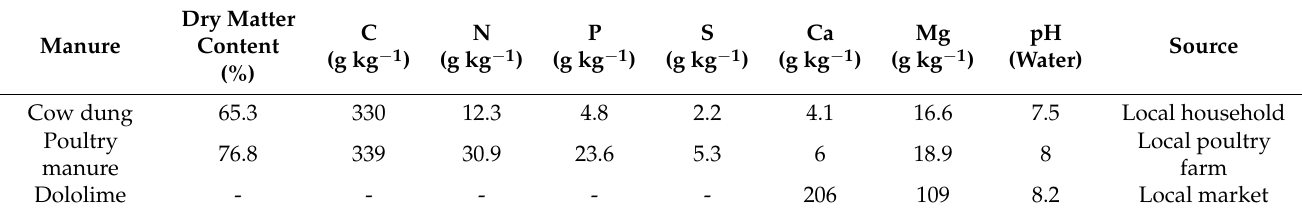
Table 2. Nutrient composition and source of manures and dololime used in the study (dry matter basis). Dry Manure